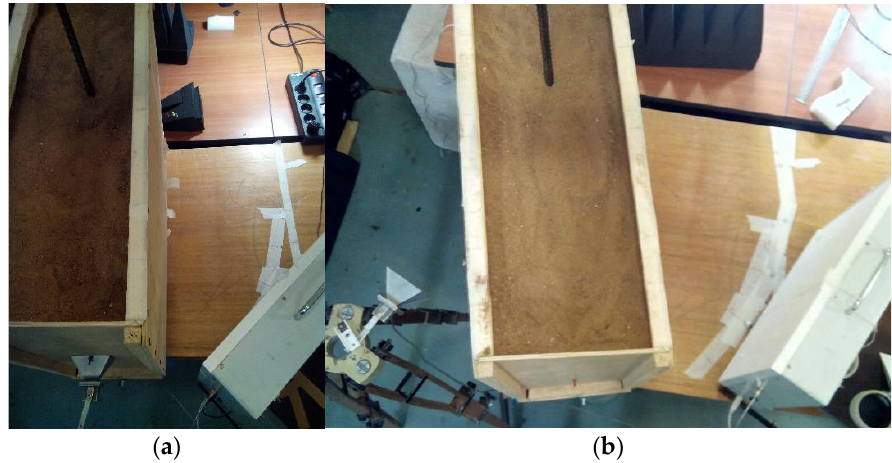
Figure 5. Estimation of scattered signal level and absorption in material medium (dry sand, estimated values : ε ’~2.5, tan δ ~0.005). Side-wall illumination ( a ) and back-side illumination ( b ).